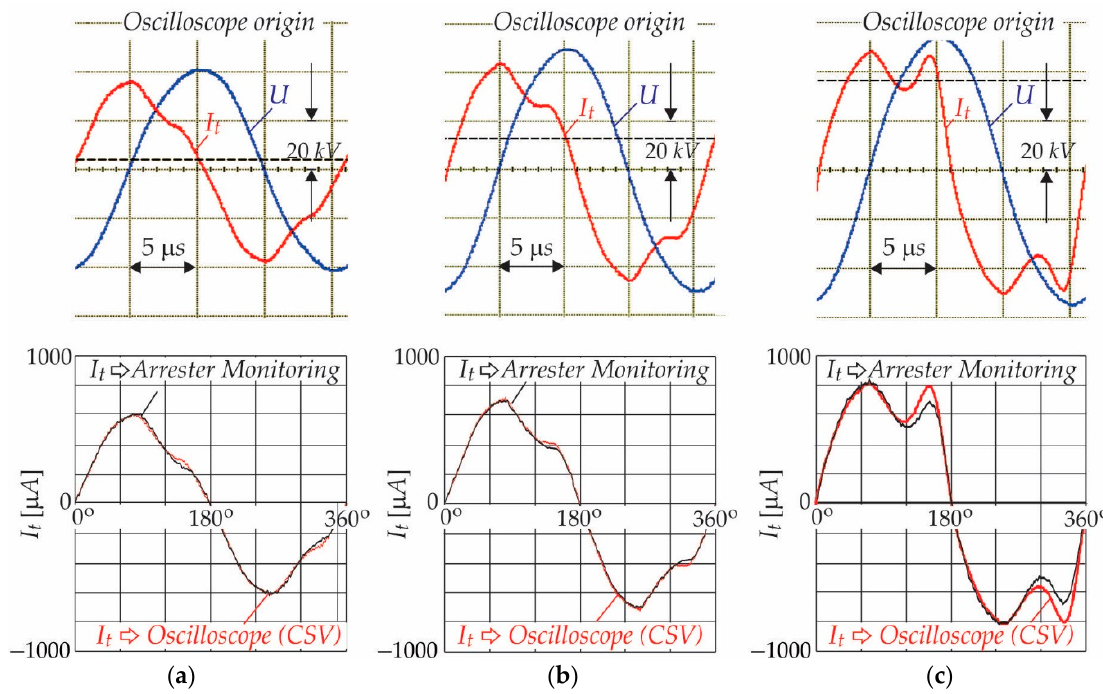
Figure 13. Verification of the calibration process when the supply voltages to the surge arrester were: ( a ) 0.9 U ; ( b ) 1.1 U ; and, ( c ) 1.275 U . Table 5. Experimental results’ verification.